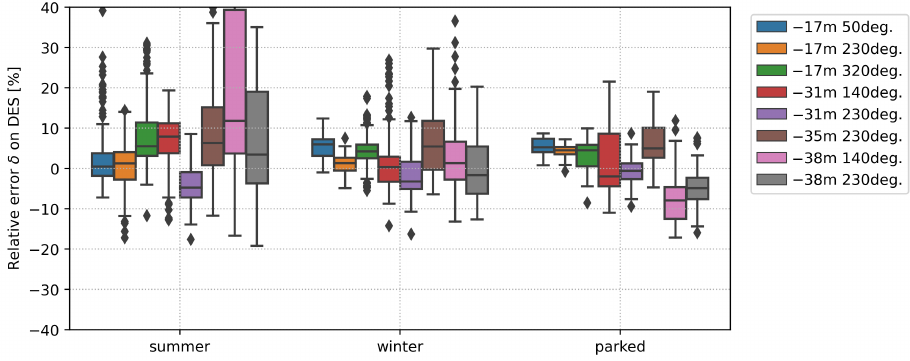
Figure 15. Relative error on DES per sensor on the MP for each validation set clustered into zones. Table 2. Accumulated relative error on DES over all samples per